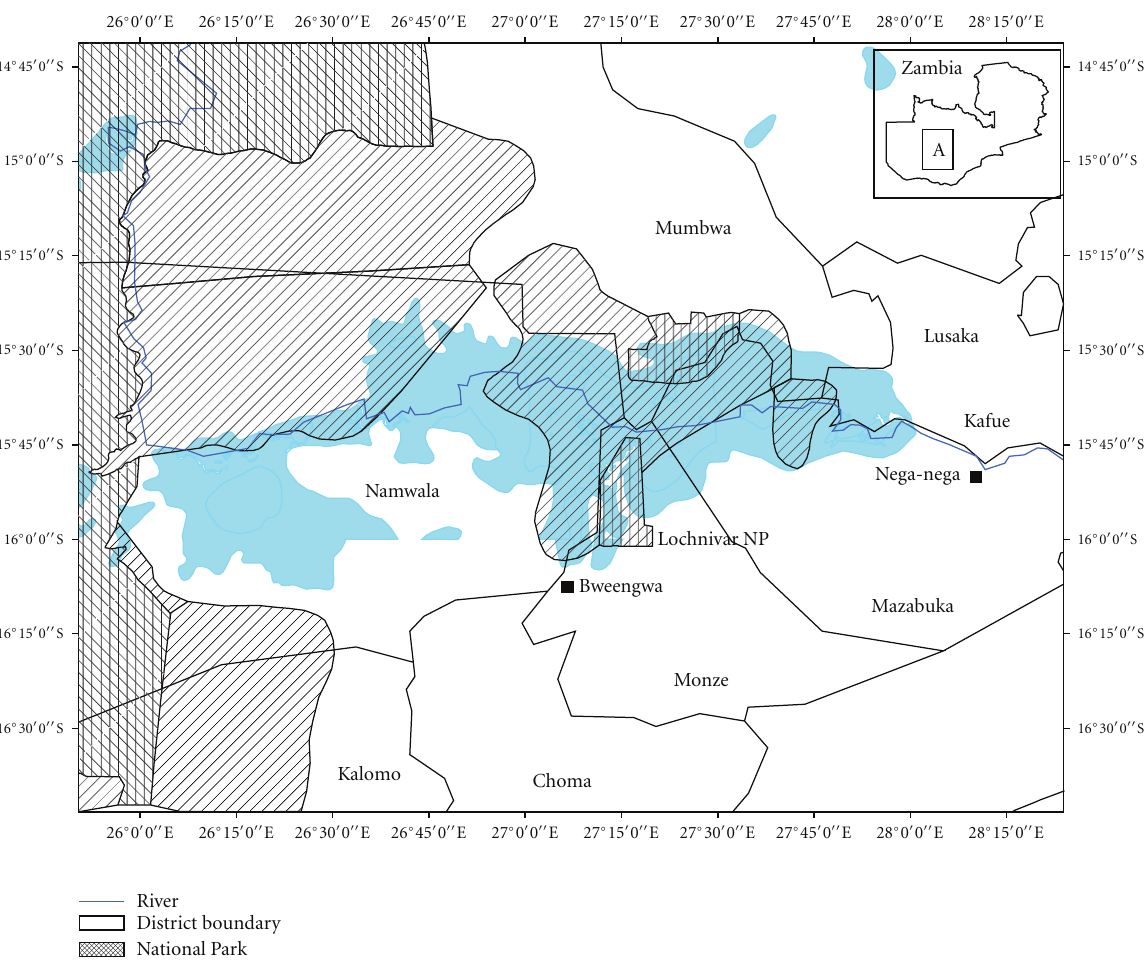
Figure 1: Map of the Kafue basin, insert Map of Zambia showing the location of the